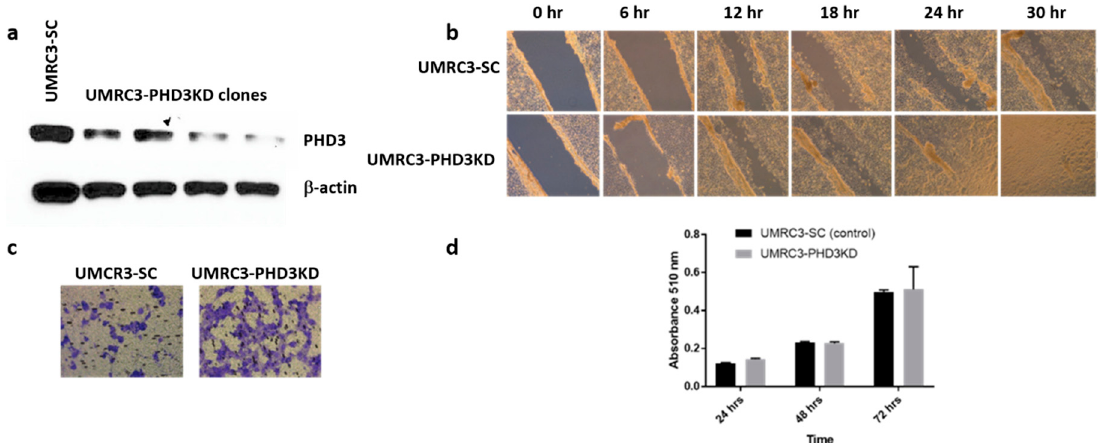
Figure 2. Effects of PHD3 knockdown in vitro. ( a ) Western analysis confirmed significant reduction of PHD3 expression in UMRC3 cells transfected with PHD3 shRNA (UMRC3-PHD3KD) relative to cells transfected with scrambled shRNA (UMRC3-SC). All subsequent in vitro and in vivo experiments used the clone with highest PHD3 knockdown efficiency. ( b ) Wound healing assays revealed that UMRC3-SC cells (top row) showed incomplete wound healing at 30 h, whereas UMRC3-PHD3KD cells (bottom row) showed complete wound healing within 24 h. 6 replicates per cell line were performed. ( c ) Migration assays revealed more extensive migration of UMRC3-PHD3KD cells compared to UMRC3-SC cells over a 12 h period. ( d ) Sulforhodamine B assays revealed that the proliferation rates of UMRC3-PHD3KD cells and UMRC3-SC were not significantly different at 24, 48, or 72 h (8 samples per time point per cell line).